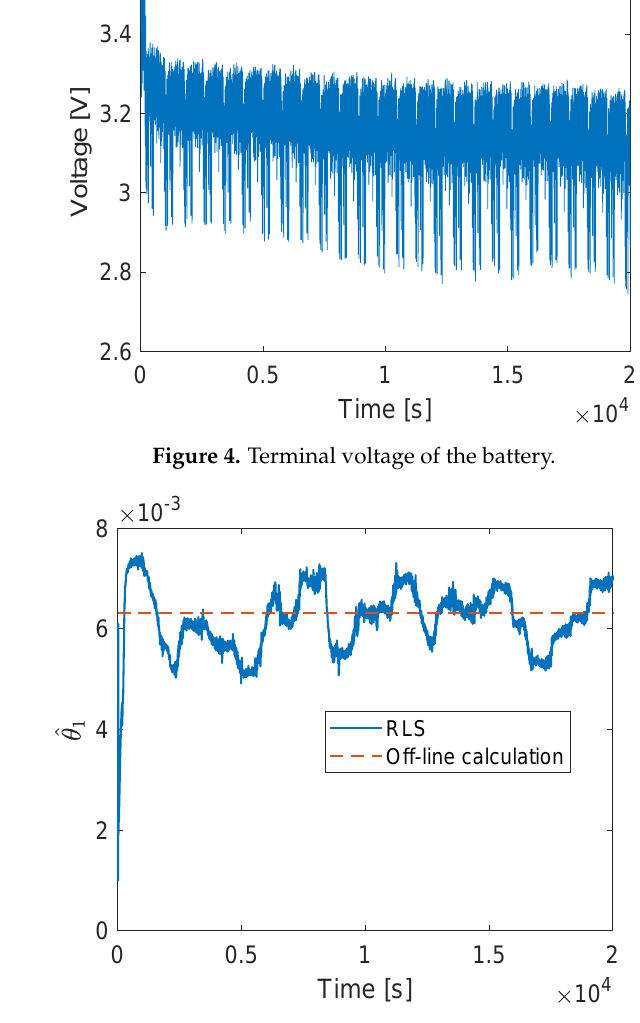
Figure 5. Comparison of the estimated results of parameter θ 1 .